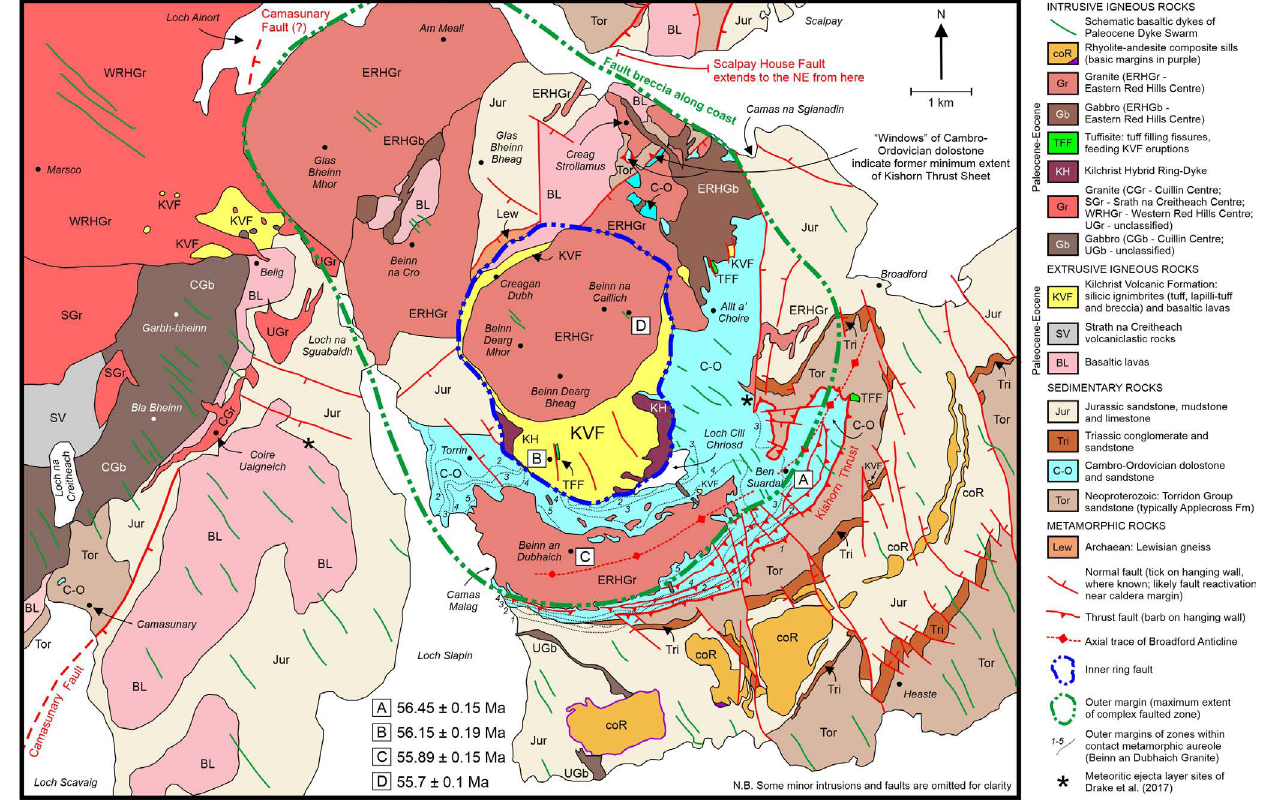
Figure 2: Map of the extent of the Paleocene Kilchrist Caldera, Isle of Skye, NW Scotland (modified from BGS